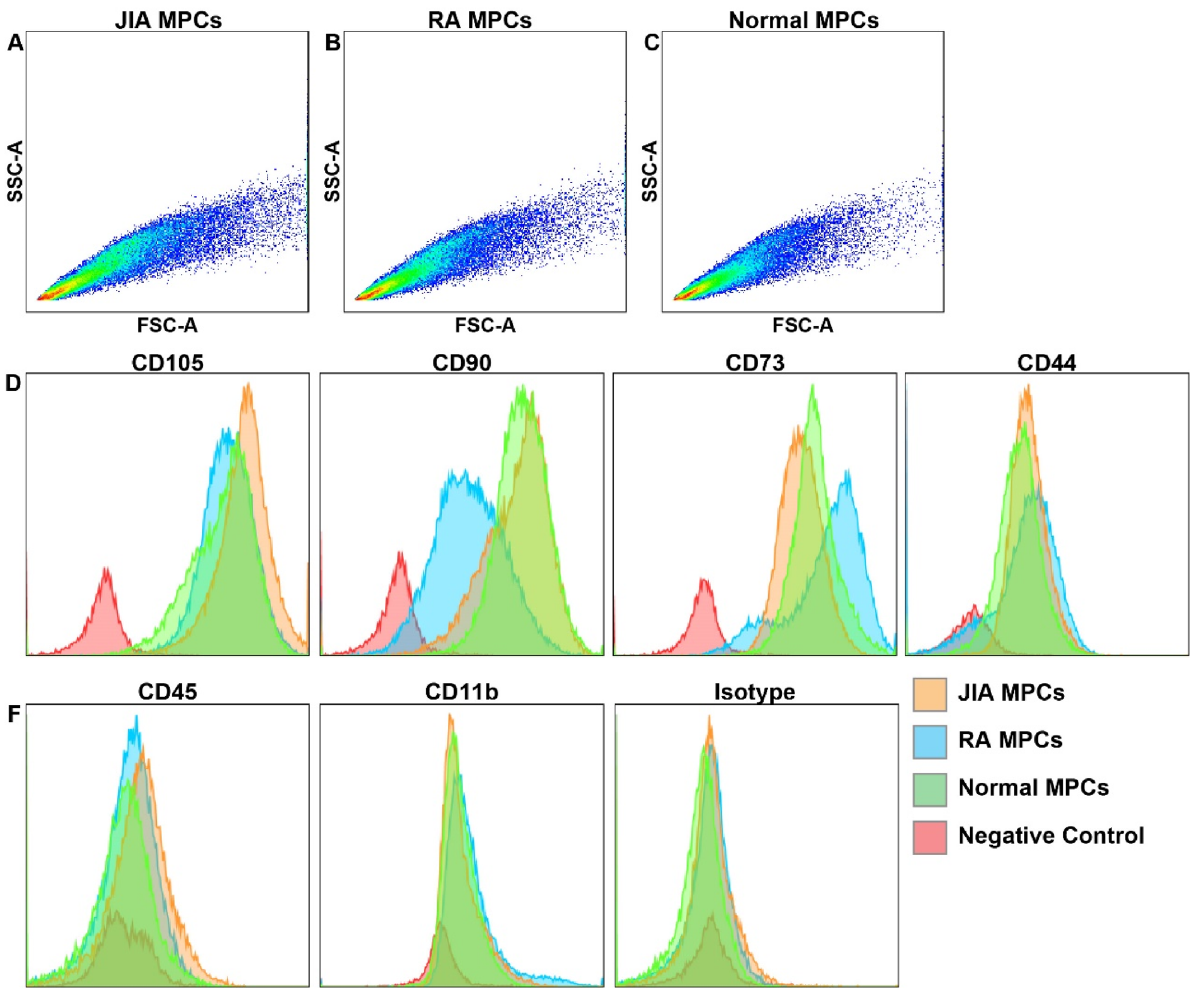
Figure 4. Cell surface marker profile of MPCs at P5. MPCs were assayed by flow cytometry for CD105, CD90, CD73, CD44, CD45, CD11b ( A - F